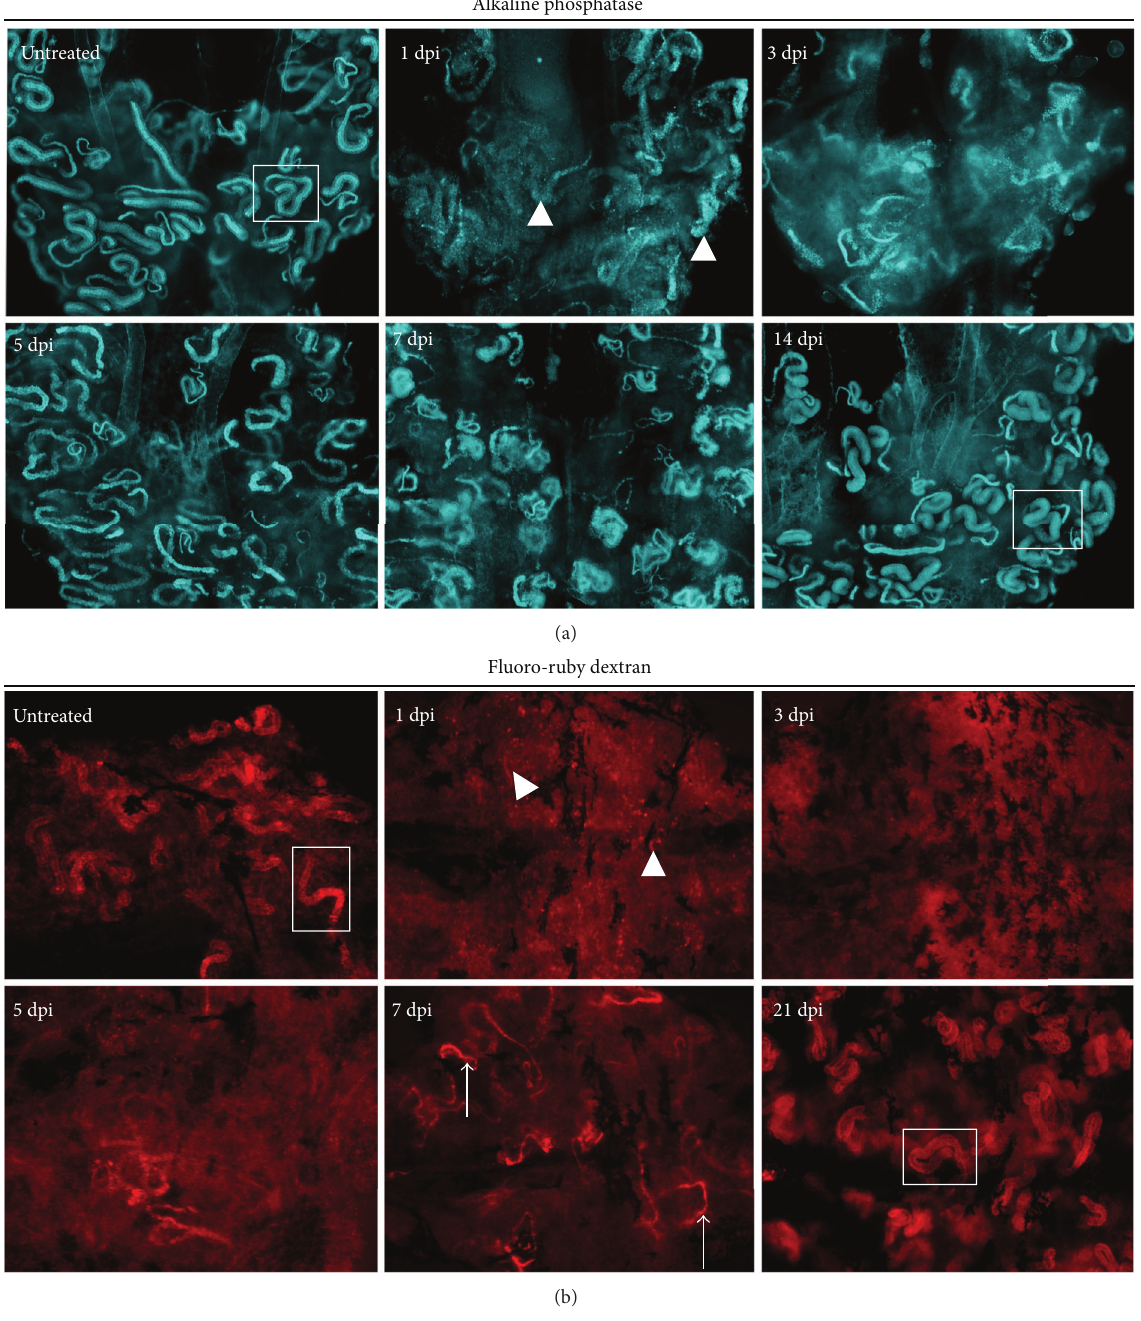
Figure 7: Changes in ELF-97 staining and proximal tubule functionality after gentamicin injury. Whole mount labeling of (a) alkaline phosphatase reactivity and (b) uptake of fluoro-ruby dextran in the zebrafish kidney during recovery from AKI. (a) Untreated kidneys contained discrete PCT-PST structures (white box) that were destroyed at 1dpi (white arrowheads). Restoration of discrete PCT-PST structures was completed by 14dpi. (b) Nephron reabsorption was visualized in injured kidneys, in which the PCT was demarcated by uptake of fluoro-ruby dextran, while at 1dpi, such structures were absent (white arrowheads). Partial uptake was sporadically observed at 5–7 dpi but was not consistent throughout the kidney organ until 21 dpi when PCT segments were distinctly visualized (white